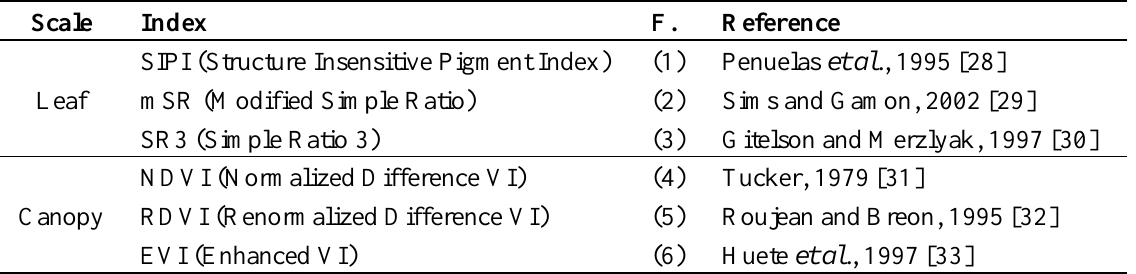
Table 2. The typical VIs selected for the assessment of tree spectral